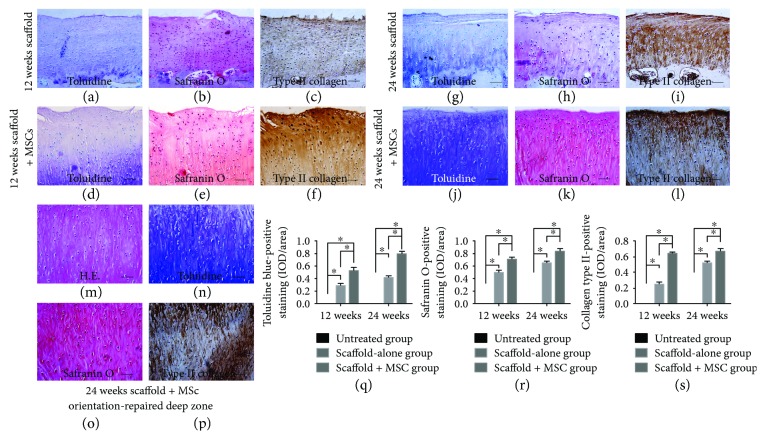
Magnified images of repaired cartilage stained with toluidine blue, safranin O, and immunohistochemical stained for collagen type II at 12 (a–f) and 24 (g–l) weeks postimplantation. The MSC-loaded scaffold group (d–f) exhibited stronger cartilage-specific matrix staining and a more aligned structure than did the scaffold-alone group (a–c) at 12 weeks postimplantation. The cell-loaded scaffold group (j–l) and the scaffold-alone group (g–i) exhibited aligned regeneration at 24 weeks postimplantation, but staining was more intense in the former group than in the latter group. (m–p) Aligned deep-level regeneration of the MSC-loaded scaffold group at 24 weeks postsurgery. (q–s) The IODs per stained area for collagen type II immunoreactivity, and toluidine blue and safranin O staining, at 12 and 24 weeks postimplantation (bars: 10 μm). ∗P < 0.05.